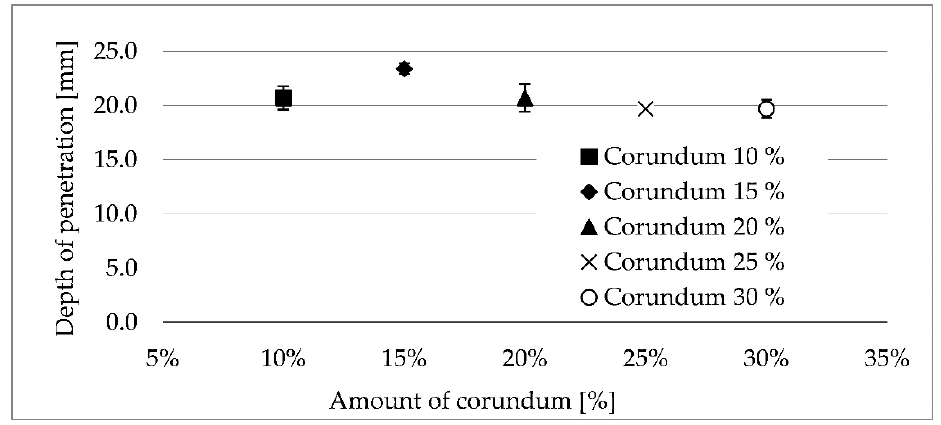
Figure 11. Depth of penetration by percentage substitution.